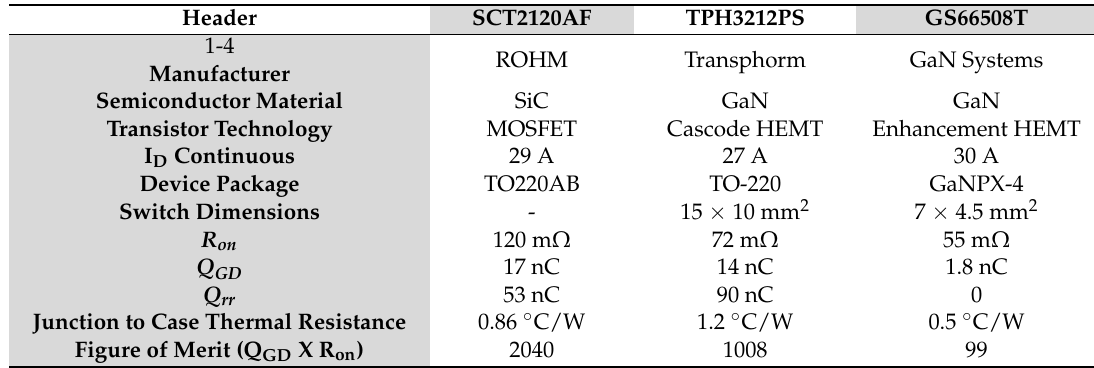
Junction to Case Thermal Resistance Figure of Merit (Q GD X R on ) 2040